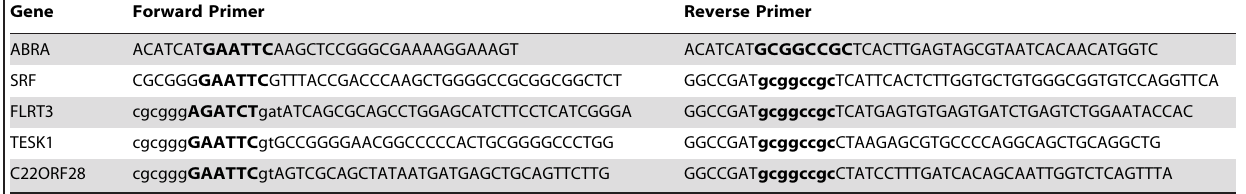
Table 1. Cloning primers.